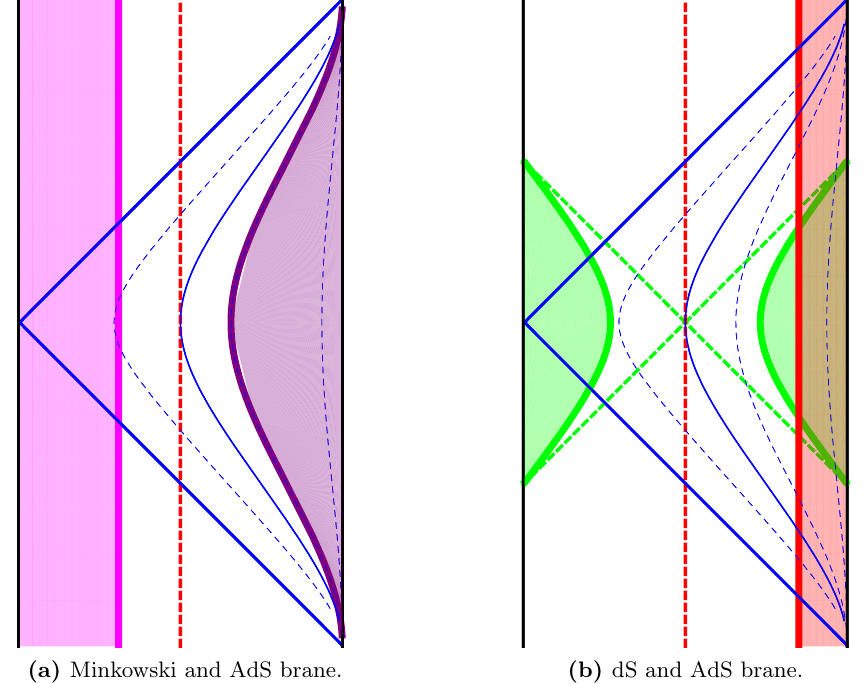
Figure 6. Vertical cross sections of mismatched branes involving an AdS